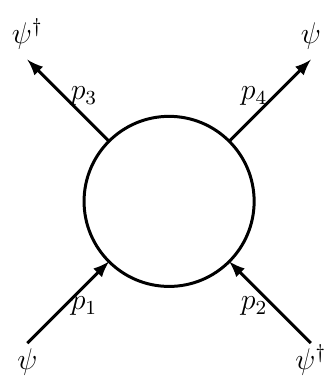
Figure 12 . 2 → 2 scattering of ψ